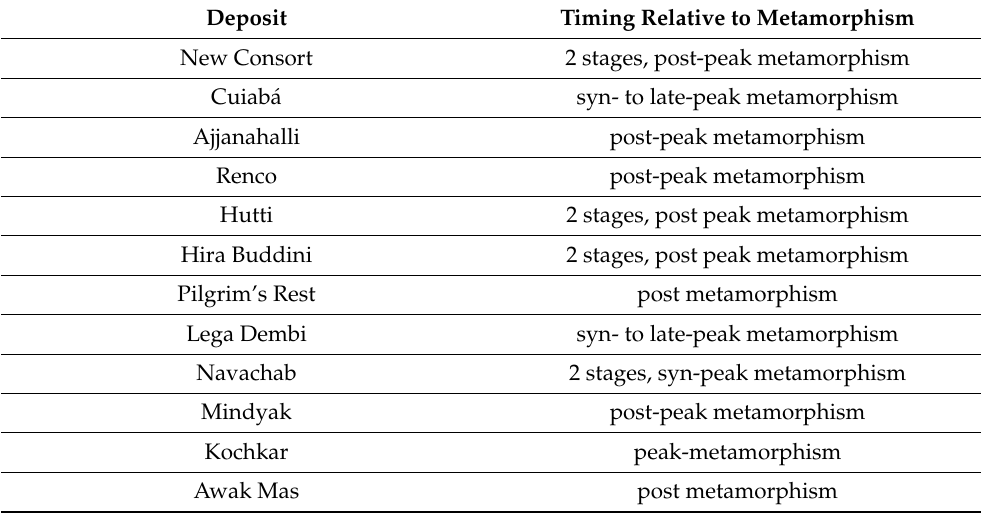
Figure 2. Ages of host rocks and mineralization. Table 4. Timing of mineralization relative to